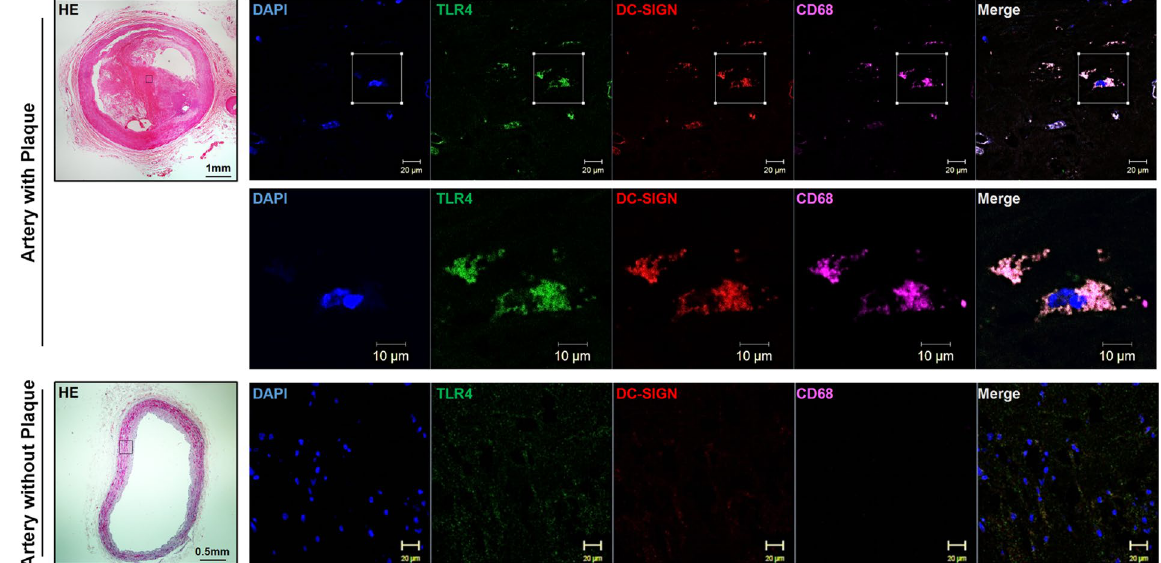
Figure 1. DC-SIGN is expressed in the macrophages of plaques and the macrophages of atherosclerotic patients. Human femoral arteries from patients with angiographic atherosclerotic plaques and internal thoracic arteries without plaques were assessed by histological and immunochemical analysis. As a continuity study, the origin of tissues is same as our previous study 22 . Sections were stained with hematoxylin and eosin or immunofluorescence stains for DC-SIGN, TLR4 and